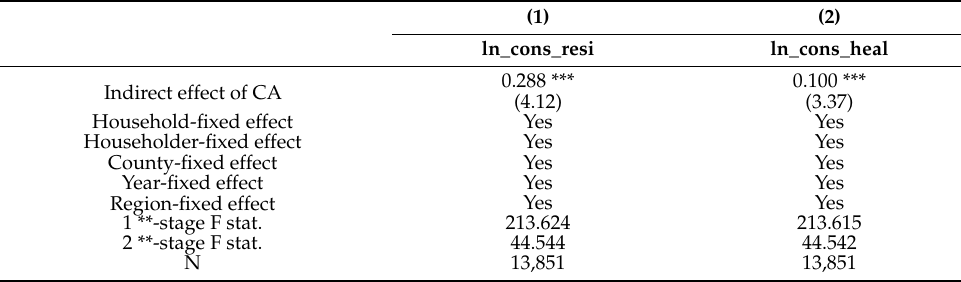
Table 8. Results of the cognitive trap effect: CMA